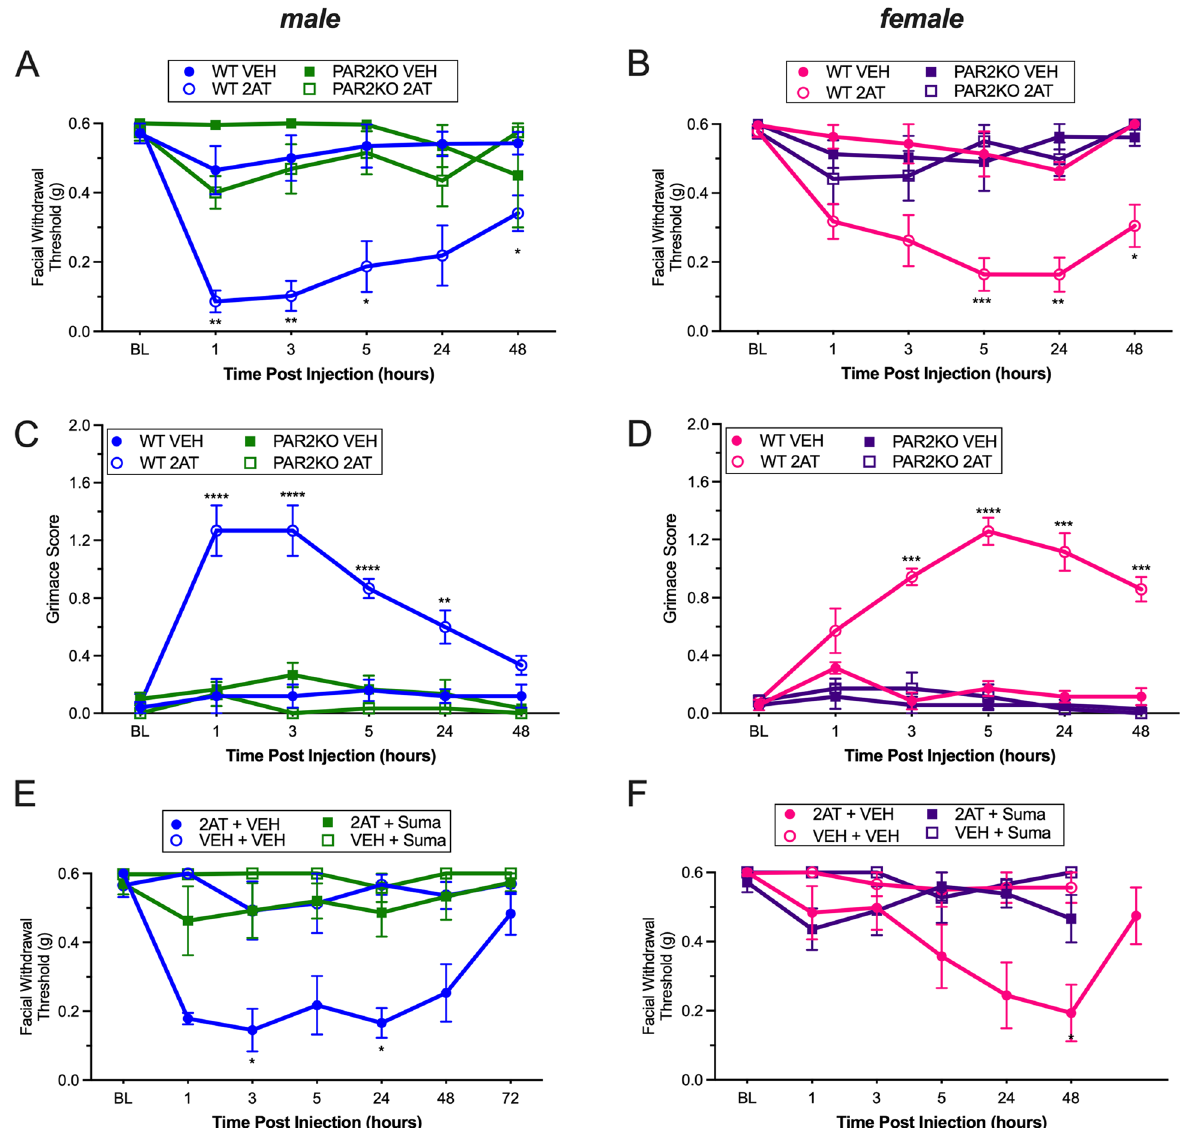
Fig. 2 Global loss of PAR2 and administration of sumatriptan inhibits dural 2AT-induced hypersensitivity . A Facial withdrawal thresholds in male PAR2KO mice and their WT controls following treatment with either 2AT or vehicle. WT male mice administered 2AT ( n 7) exhibited significantly decreased = withdrawal thresholds compared PAR2KO mice treated with 2AT ( n 7) and both WT ( n 4) and PAR2KO ( n 6) mice treated with vehicle. B Facial = = = withdrawal thresholds in female PAR2KO mice and their WT controls following treatment with either 2AT or vehicle. WT female mice administered 2AT ( n 7) exhibited significantly decreased withdrawal thresholds compared PAR2KO mice treated with 2AT ( n 8) and both WT ( n 7) and = = = PAR2KO ( n 6) mice treated with vehicle. C Grimace scores of male PAR2KO mice and their WT controls following dural application of either 2-AT = or vehicle. WT male mice administered 2AT exhibited significantly increased grimacing compared to PAR2KO mice treated with 2AT and both WT and PAR2KO mice treated with vehicle. D Grimace scores of female PAR2KO mice and their WT controls following dural application of either 2AT or vehicle. WT female mice administered 2AT exhibited significantly increased grimacing compared to PAR2KO mice treated with 2AT and both WT and PAR2KO mice treated with vehicle. E Facial withdrawal thresholds in male WT mice administered 2AT and sumatriptan. Sumatriptan significantly attenuates withdrawal thresholds induced by 2AT (2AT Suma; n 5) compared to 2AT Veh ( n 6) F Facial withdrawal thresholds in female WT + = + = mice administered 2AT and sumatriptan. Sumatriptan significantly attenuates withdrawal thresholds induced by 2AT (2AT Suma; n 7) compared + = to 2AT Veh ( n 7). * p < 0.05, ** p < 0.01, *** p < 0.001, **** p < 0.0001. Data are represented as mean + = ±